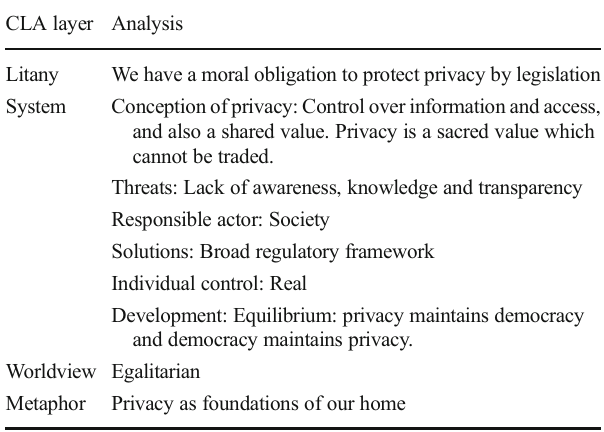
Causal layered analysis of privacy as foundations of our home ( n = 7) CLA layer